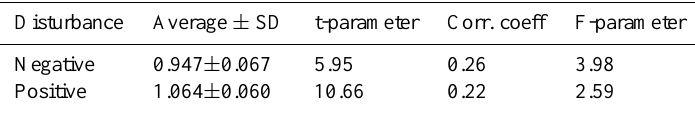
Table 2. Average δ Nm E ± SD value, along with the Student t-parameter, and the correlation coefficient between δ Nm F2 and δ Nm E, along with the Fisher F-parameter for negative and positive F2-layer Q-disturbances. Disturbance Average ± SD t-parameter Corr. coeff